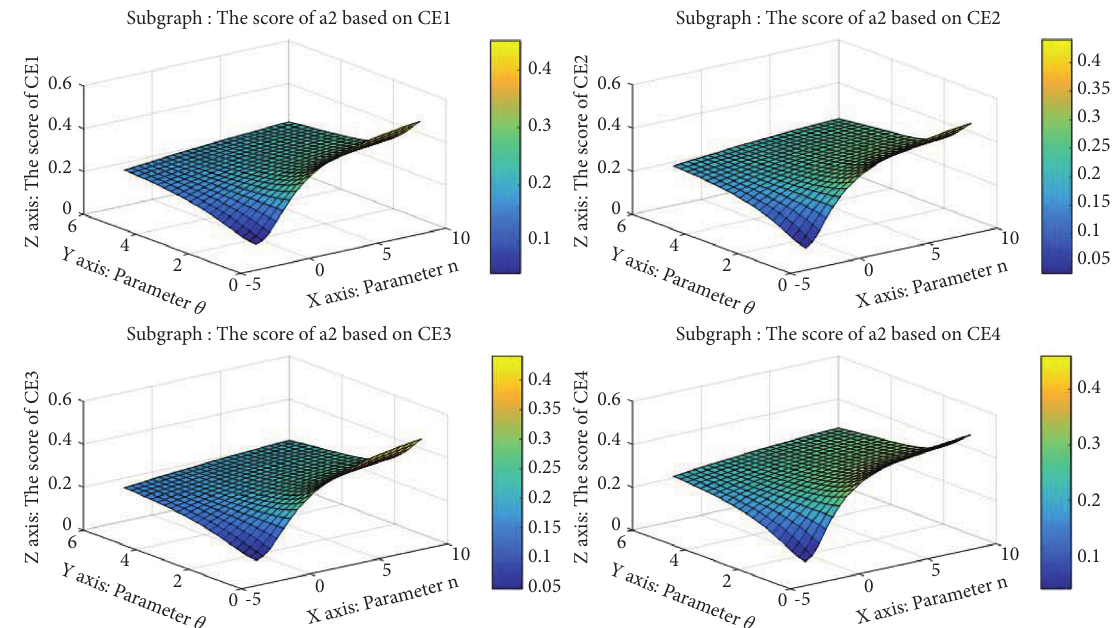
Figure 3: Score of alternative a